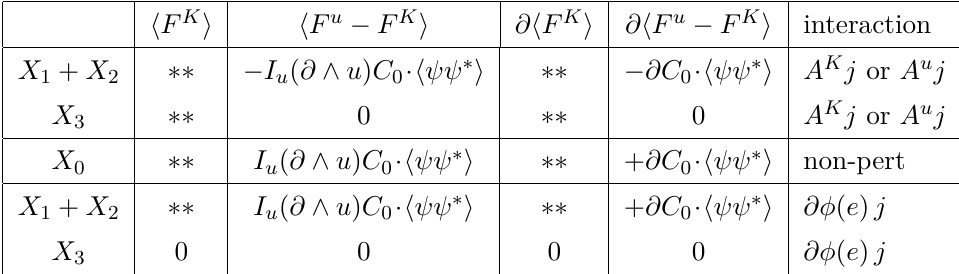
Table 2 . Cancellations of non-local contributions. (Entries indicated by ∗∗ are identical to table 1.)